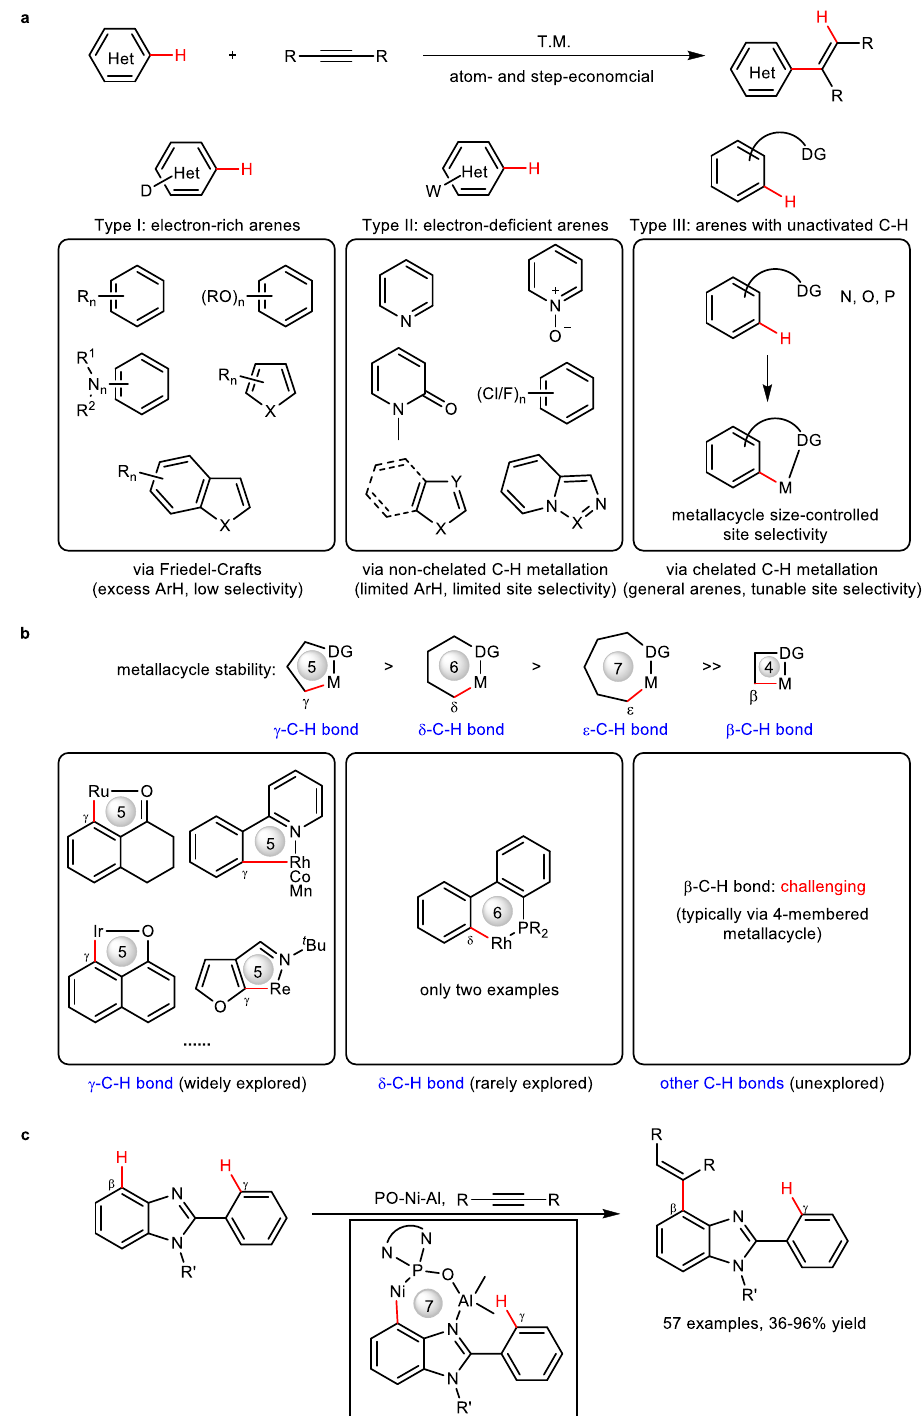
Fig. 1 TM-catalyzed hydroarylation of alkynes with (hetero)arenes. a Three types of hydroarylations of alkynes and (hetero)arenes: electron-rich arenes (type I), electron-de fi cient arenes (type II), and general arenes with unactivated C(sp 2 ) − H bonds (type III). b Stability of metallacycles and reported various metallacycle-involved hydroarylations: γ -C − H bond-activation-involved hydroarylation (widely explored); δ -C − H bond-activation-involved hydroarylation (rarely explored); β -C − H bond-activation-involved hydroarylation (elusive challenge); c β -C − H bond-involved hydroarylation via 7-membered metallacycles (this work). T.M. = transition metal. Het = heterocycle, D = electron-donating group. W = electron-withdrawing group. DG = directing group. PO = phosphine oxide